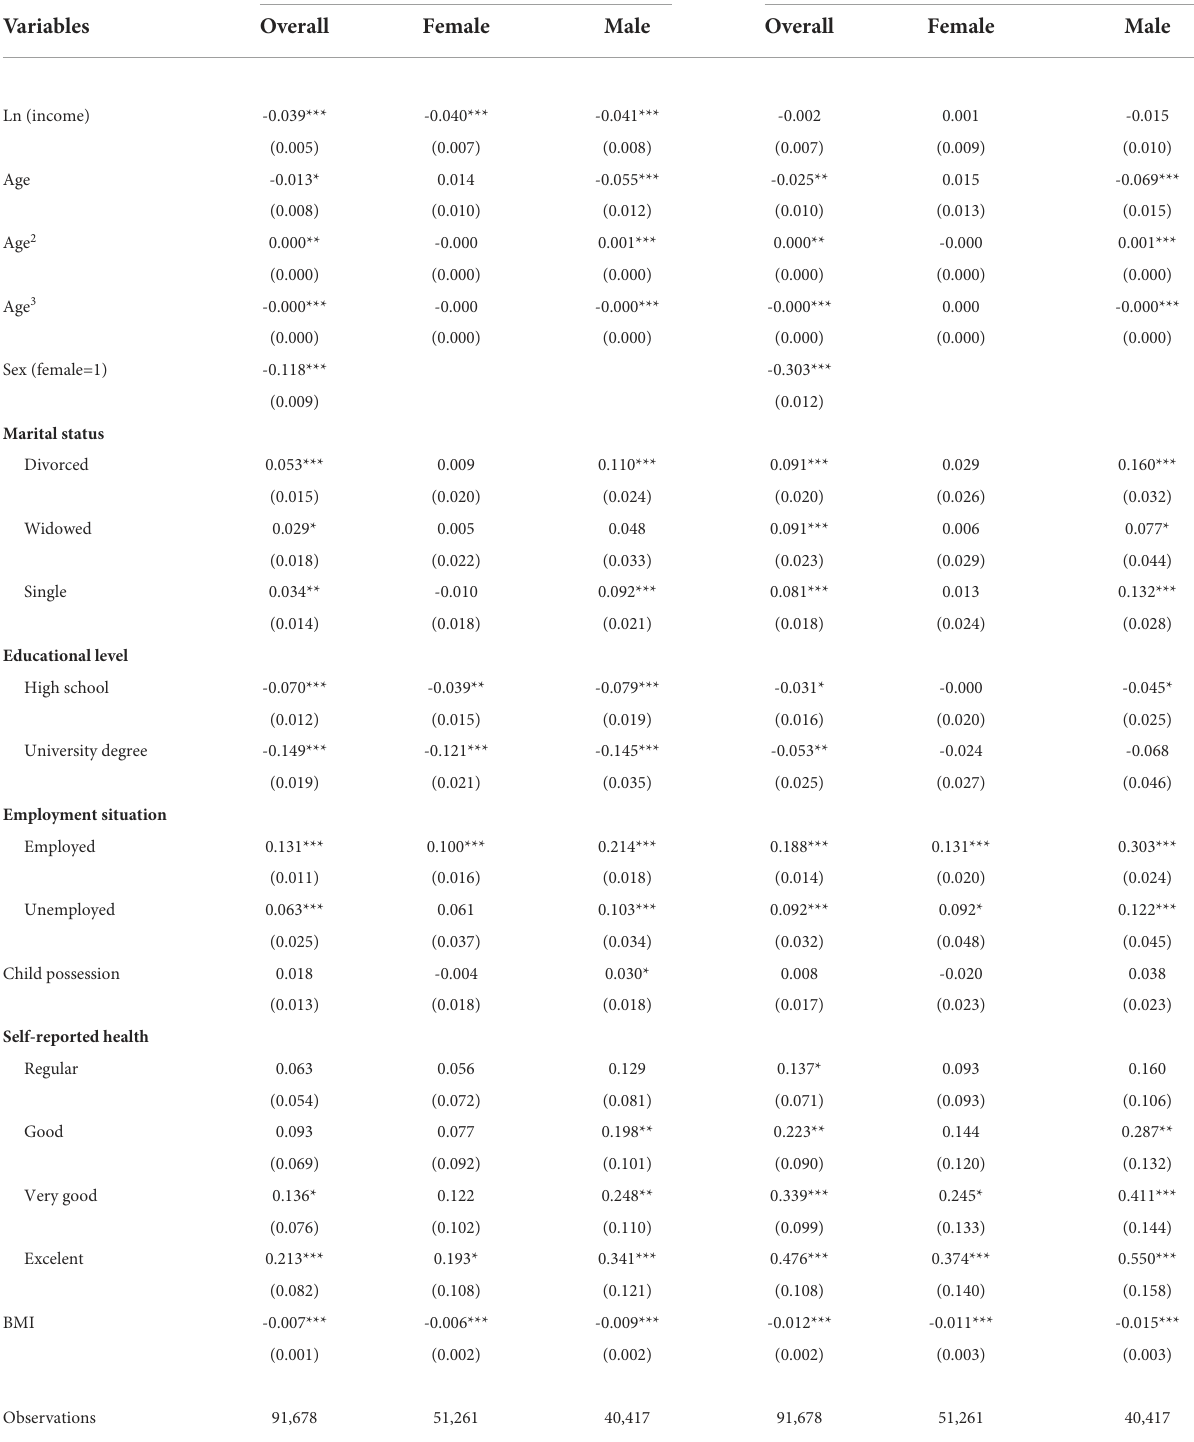
TABLE 3 Estimation by Heckman two-stage